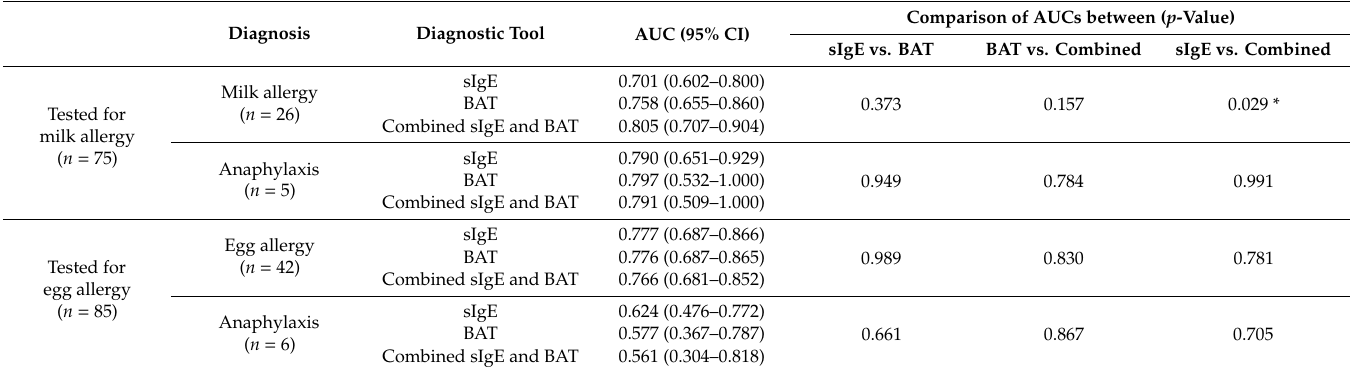
Table 3. Diagnostic performance of allergy tests in milk and egg allergy and anaphylaxis for total subjects.